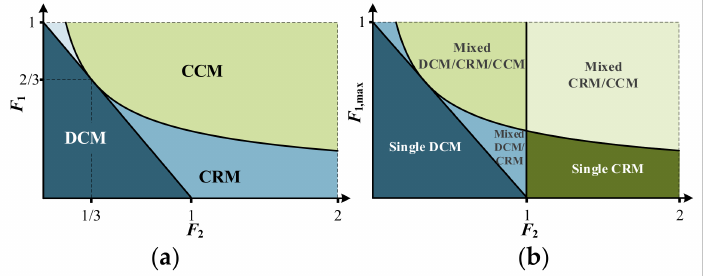
Figure 8. Mapping of operation regions under TACC control. ( a ) Instant operation modes with F 1 and F 2; ( b ) mode mixing in a half-line cycle with F 1,max and F 2